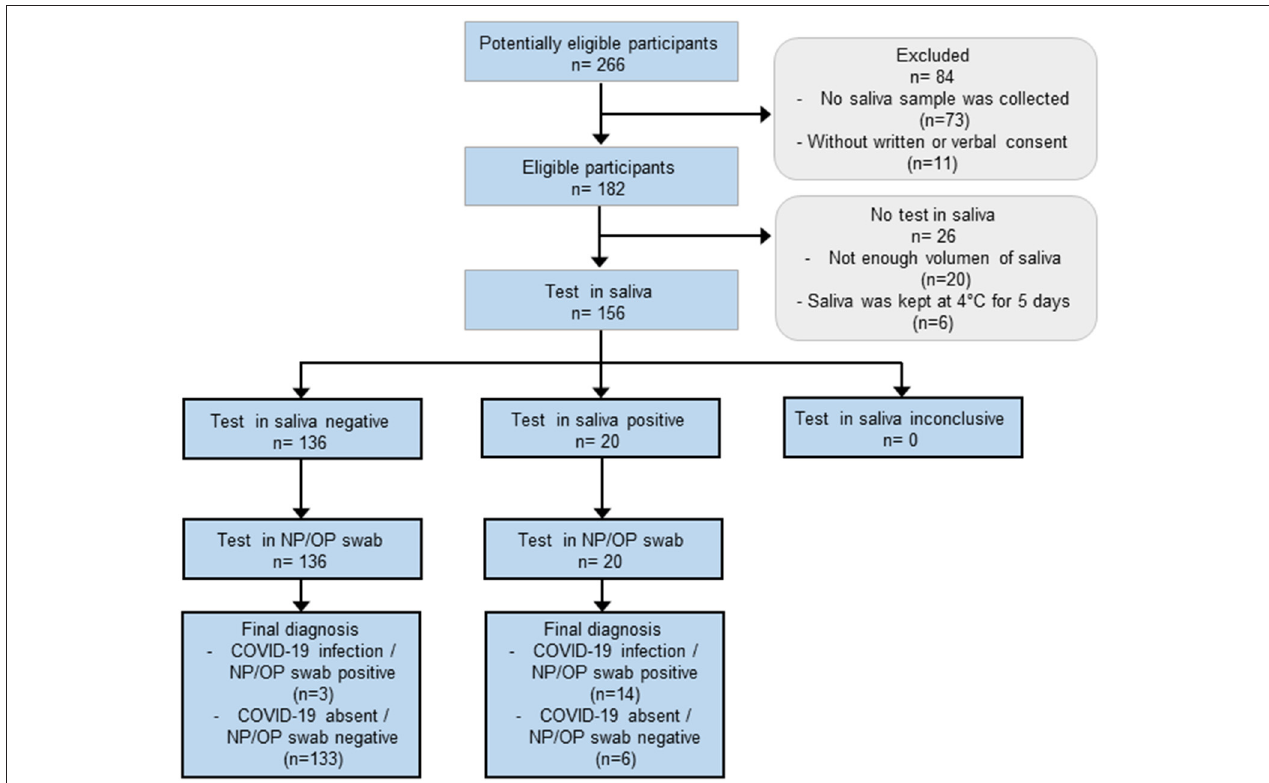
FIGURE 1 | Flow of pediatric patients whose results were used to calculate the sensitivity and specificity of the test in saliva. This group was comprised of children and adolescents who attended to the hospital with clinical symptoms related to SARS-CoV-2 infection, hospitalized patients who showed respiratory symptoms while recovering from a disease other than COVID-19, and non-probable COVID-19 patients who attended to the hospital for routine clinical analyses before a programmed surgery. The characteristics of these participants are shown in Tables 1 , 2 .